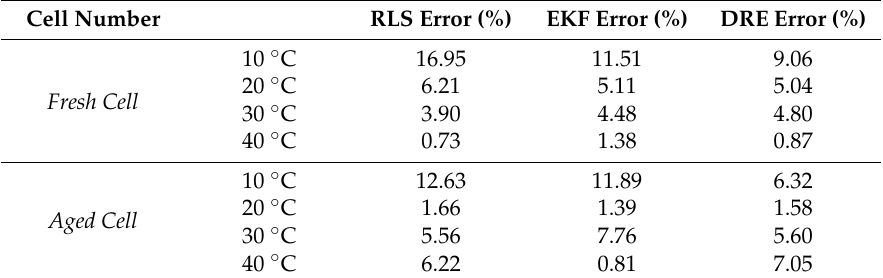
Table 3. Comparison of the averaged percent error from DRE algorithm, RLS algorithm, and EKF algorithm for fresh and aged cell at temperatures of 10 °C, 20 °C, 30 °C, and 40 °C.